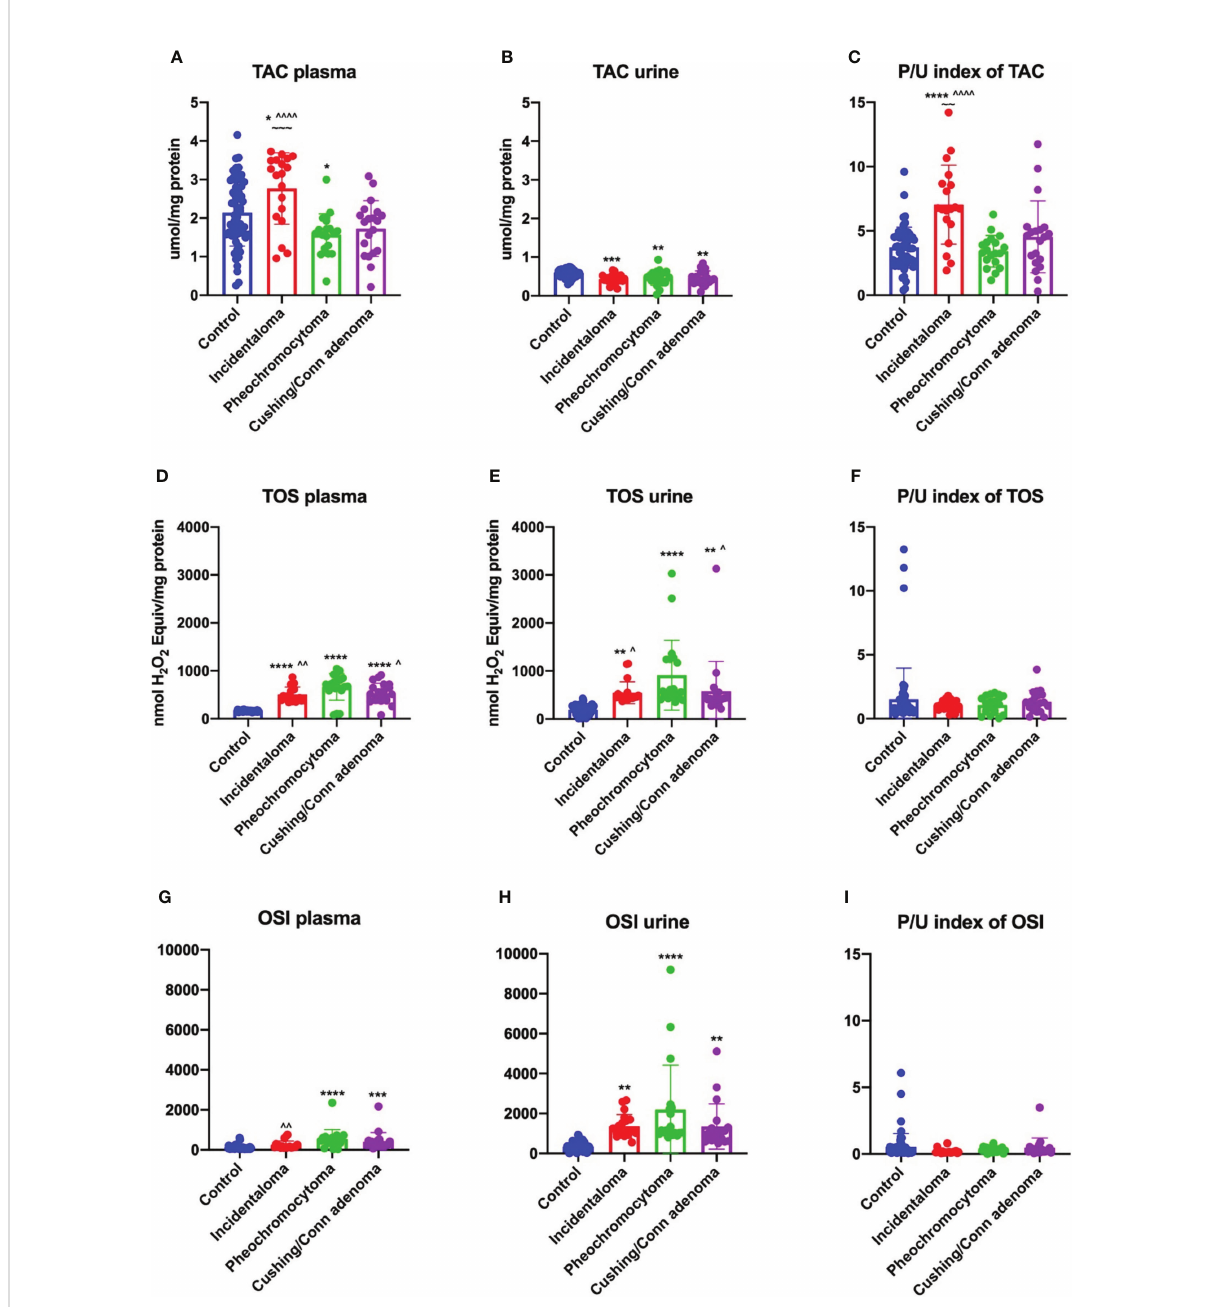
FIGURE 1 Plasma TAC (A) , TOS (D) and OSI (G) , urine TAC (B) , TOS (E) and OSI (H) , and plasma/urine index of TAC (C) , TOS (F) and OSI (I) of the controls, incidentaloma, pheochromocytoma, and Cushing ’ s/Conn ’ s adenoma patients. Results are presented as mean with standard deviation. *p<0.05, **p<0.01, ***p < 0.001, ****p < 0.0001 indicate signi fi cant differences from the controls; ^ p<0.05, ^^ p<0.01, ^^^^p<0.0001 indicate signi fi cant differences from the pheochromocytoma group; ~~ p<0.01, ~~~ p<0.001 indicate signi fi cant differences from the Cushing ’ s/Conn ’ s group; total antioxidant capacity (TAC), total oxidant status (TOS) and oxidative status index